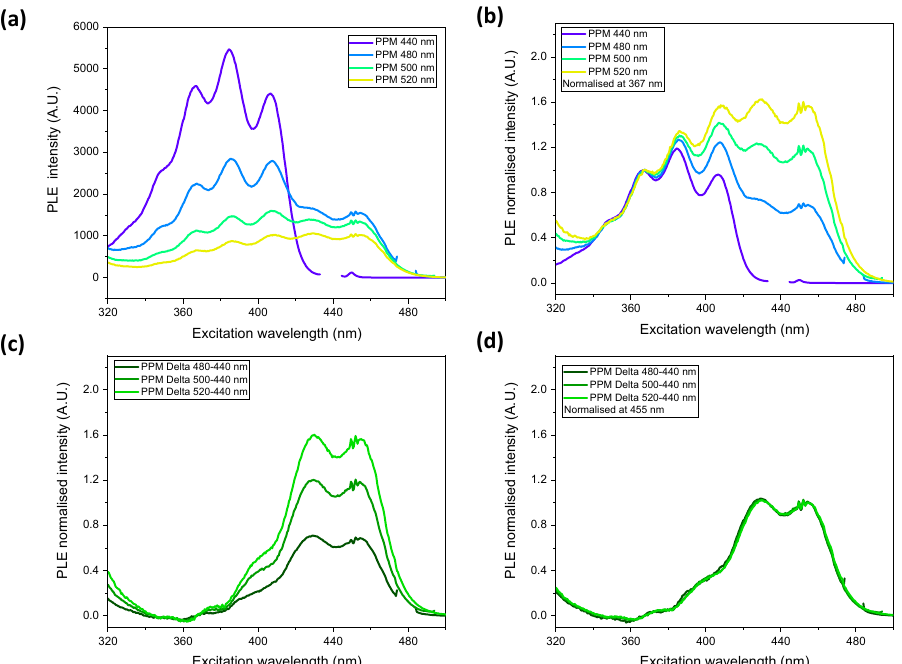
Figure 2. ( a ) PLE spectrum of PPM at detection wavelengths of 440 nm (violet curve), 480 nm (blue curve), 500 nm (green curve) and 520 nm (yellow-green curve); ( b ) normalized PLE spectra related to ( a ); ( c ) PLE spectra of ( b ) after subtraction of the detection wavelength at 440 nm (blue phase); ( d ) normalized PLE spectra related to ( c ).